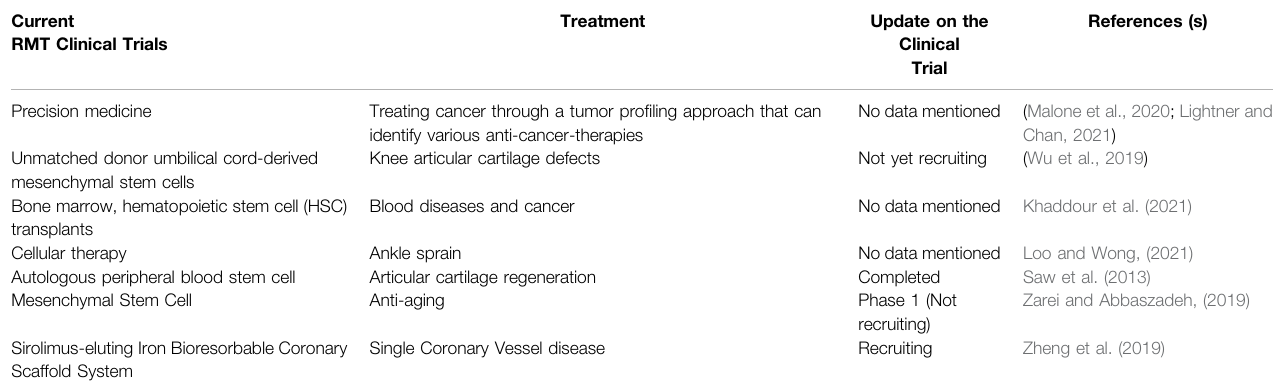
TABLE 3 | Current regenerative medicine therapy (RMT) in clinical